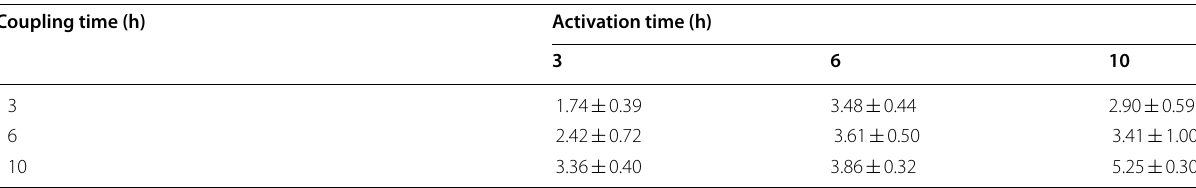
Table 1 The amounts of anti‑CD8a Ab conjugated to the PLGA‑PEG‑COOH NPs. The amounts (µg) of antibodies conjugated to 1 mg of the PLGA‑PEG‑COOH NPs when antibodies were initially added at 25 µg per 1 mg of NPs was measured by BCA assay (n mean SD) ±